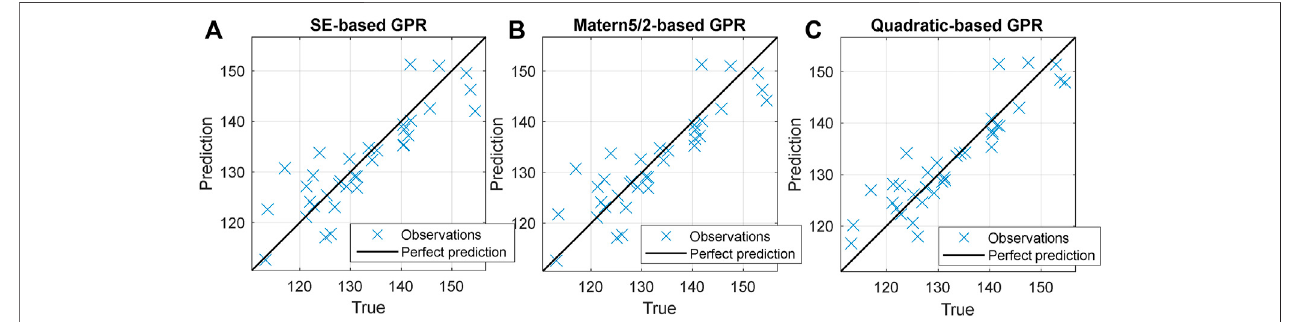
FIGURE 4 | Prediction versus true plots using a GPR-based data-driven model with different ARD kernels: (A) SE kernel, (B) Matern5/2 kernel, and (C) quadratic kernel.